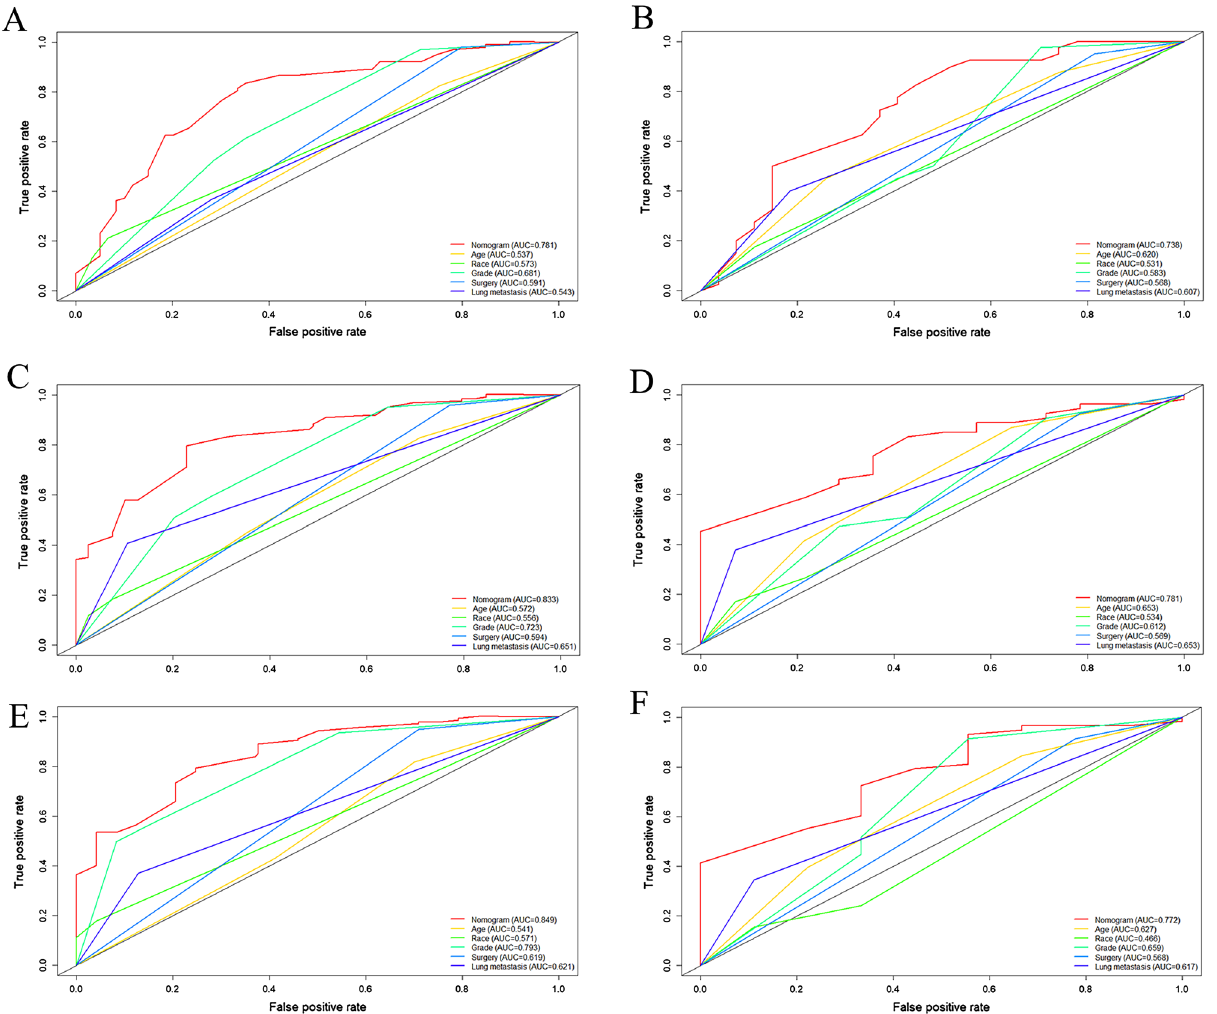
Figure 5. Comparison of the values of area under the curve between nomogram and single independent factors. 6-month in the training set ( A ); 12-month survival in the training set ( C ); 18-month survival in the training set ( E ); 6-month survival in the validation set ( B ); 12-month survival in the validation set ( D ); 18-month survival in the validation set ( F